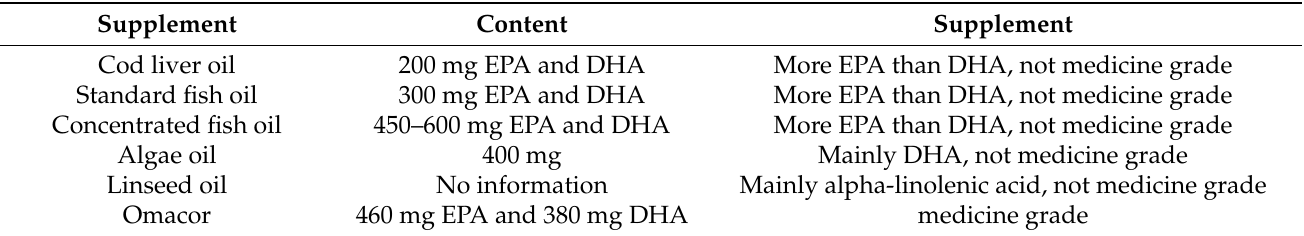
Table 2. EPA and DHA content of commonly used supplements